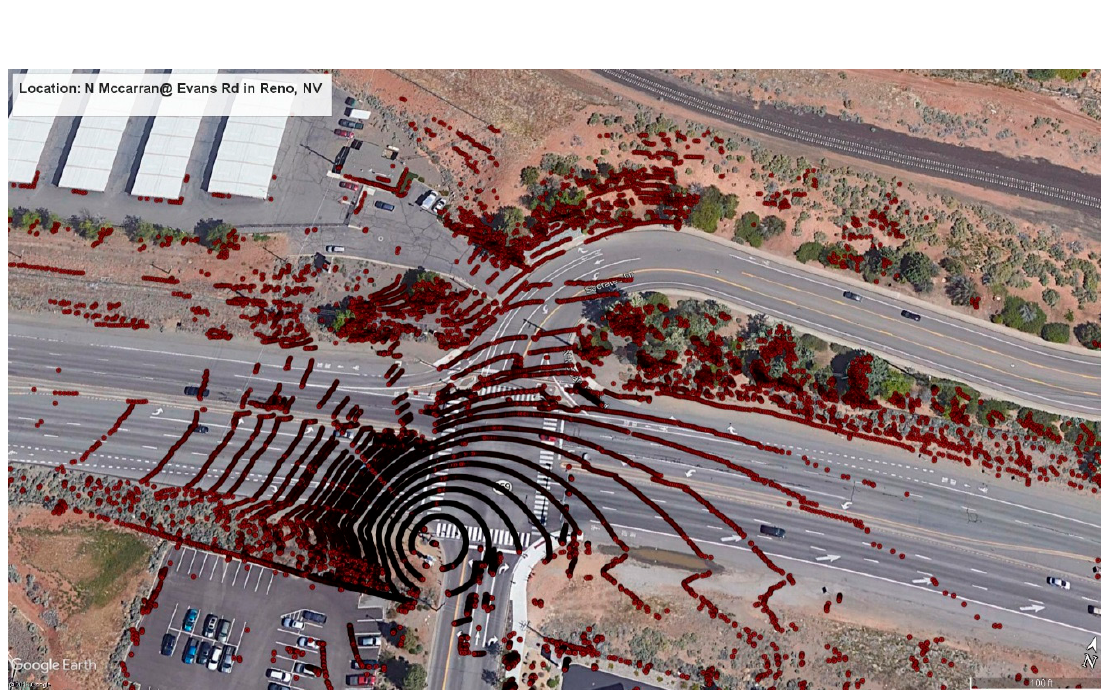
Figure 9. LiDAR data mapped into Google Earth.